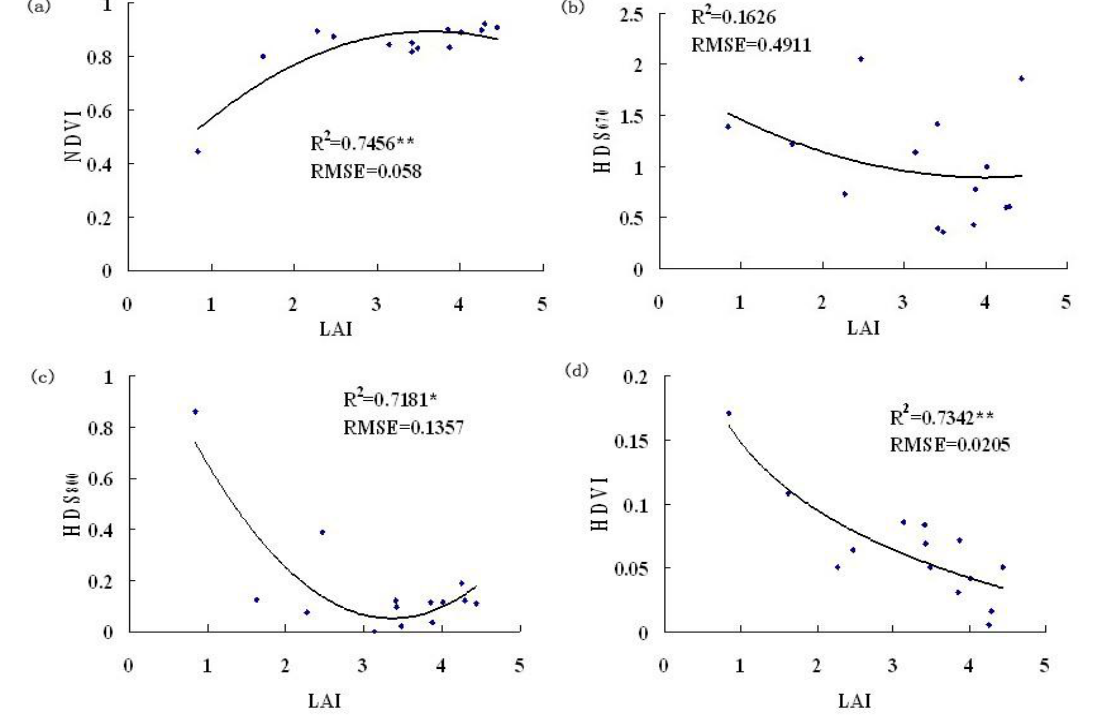
Figure 4. Correlationship between LAI and (a)HDS 670 , (b)HDS 800 , (c)NDVI, and (d)HDVI using the data in situ measurements ( significance level of the relationship is indicated: **P<0.05, *P<0.01) The new HDVI index was also successfully applied to CHRIS/PROBA remote sensing image data. Here among all the bands, we chose L8 (mid wavelength 672 nm) and L14 (mid wavelength 781 nm), two channels, the closest to 670 nm and 800 nm. We also compared the results of a variety of fitting curves. The results show that the polynomial is the best choice for the NDVI, HDS 781 , and HDVI. For the HDS 672 , the optimal fit is logarithmic (Table 5). The table also shows that there is a better relationship between the vegetation index HDVI and LAI. As seen on the scatter diagrams in Fig. 5 (b, c), a different predicting ability is also observed for the two HDS